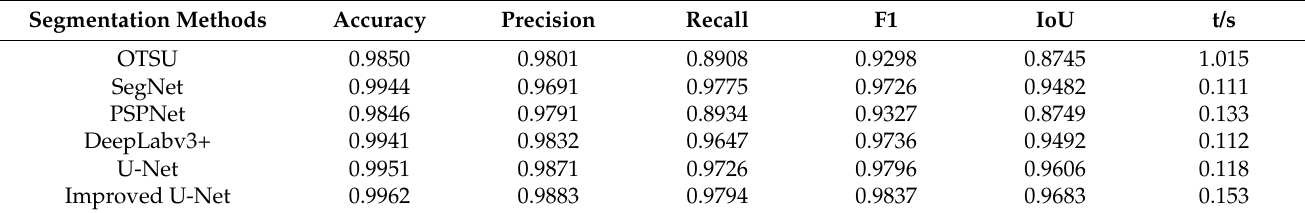
Table 5. Comparison of segmentation performance on different methods.